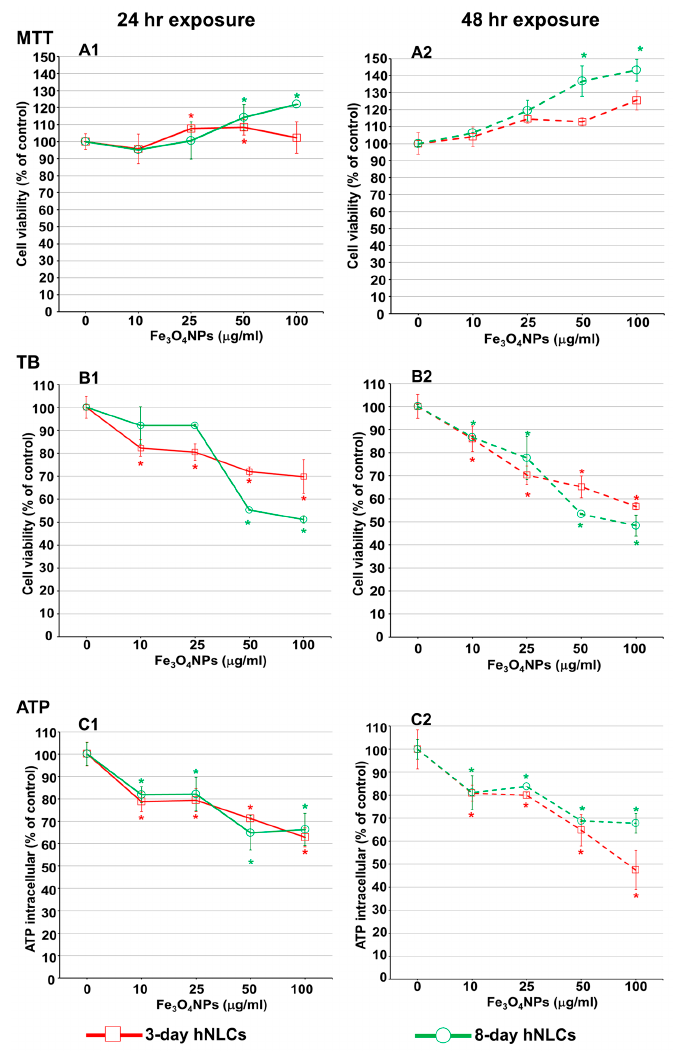
Figure 7. Cytotoxic effects of Fe 3 O 4 NPs on hNLCs treated, at day 3 and 8 of transdifferentiation, for 24 and 48 h with increasing Fe 3 O 4 NPs concentrations (10–100 μ g/mL). Evaluation by three cell viability assays. ( A1 , A2 ) Mitochondrial activity assessed by MTT assay; ( B1 , B2 ) cell viability evaluation by Trypan blue (TB) test; and ( C1 , C2 ) evaluation of intracellular ATP content. Data are expressed as percentage of viable cells (% of each control) and represent the mean ± S.D. * p < 0.05, statistical